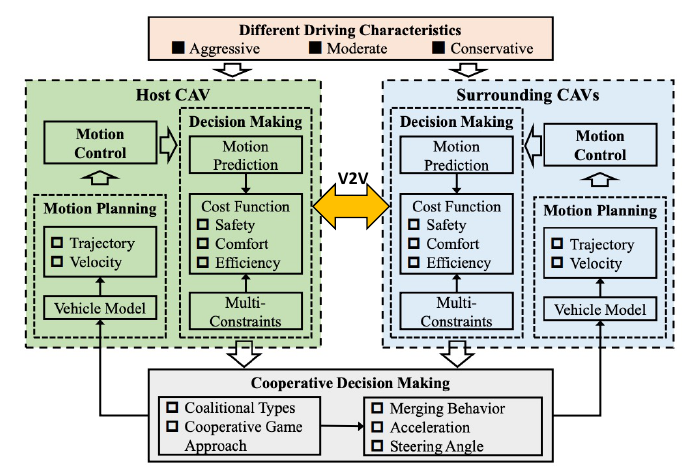
Figure 6. Coalitional game theory based decision-making framework for CAVs.